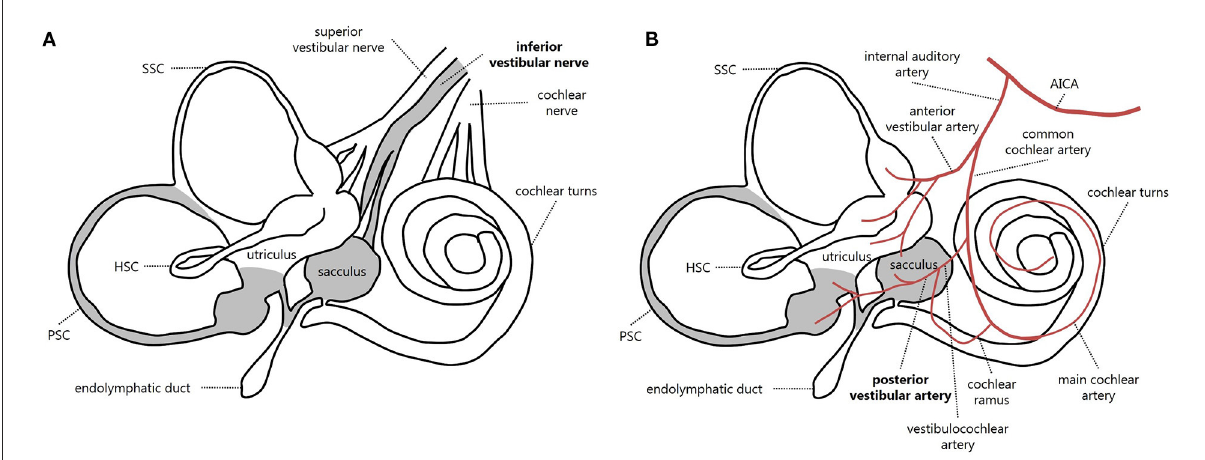
FIGURE4 Schematic representation of inner ear innervation (A) and vascular supply (B) showing possible pathomechanisms accounting for an acute loss of PSC and saccular function [modified from (21)]. Labyrinthine receptors innervated by the inferior vestibular nerve and mainly supplied by the posterior vestibular artery are gray. AICA, anterior-inferior cerebellar artery; HSC, horizontal semicircular canal; PSC, posterior semicircular canal; SSC, superior semicircular